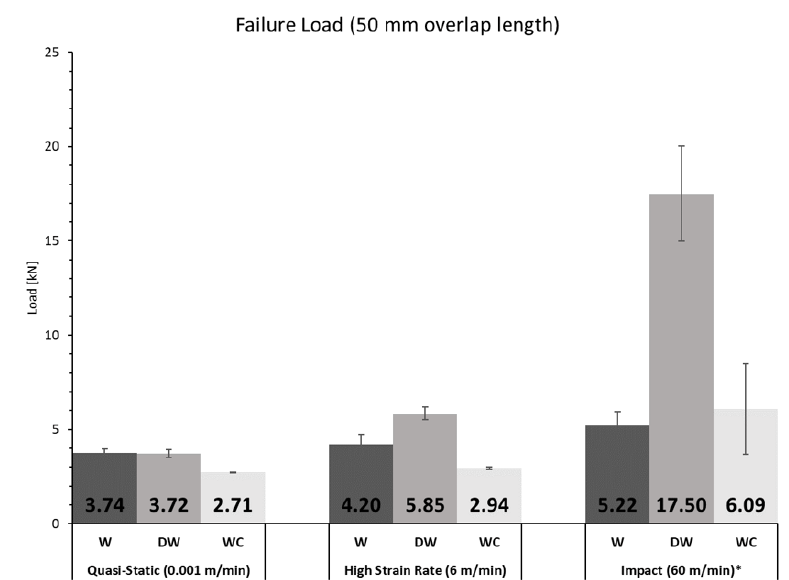
Figure 22. Summary of the failure load for each configuration and cross-head rate (* For DW 120 m/min are considered since the joint did not break for 60